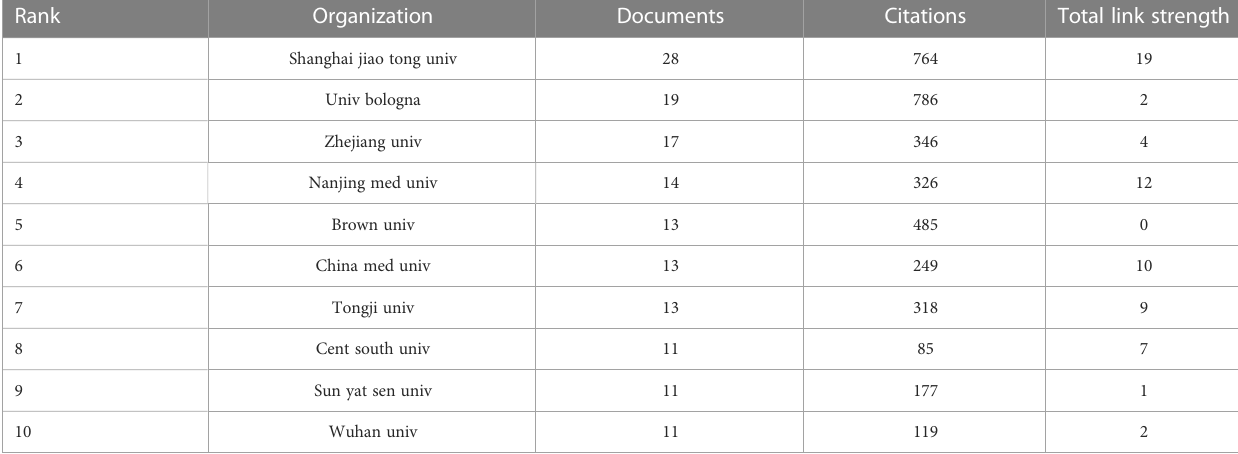
TABLE 4 Top 10 institutions with published articles in the fi eld of osteosarcoma